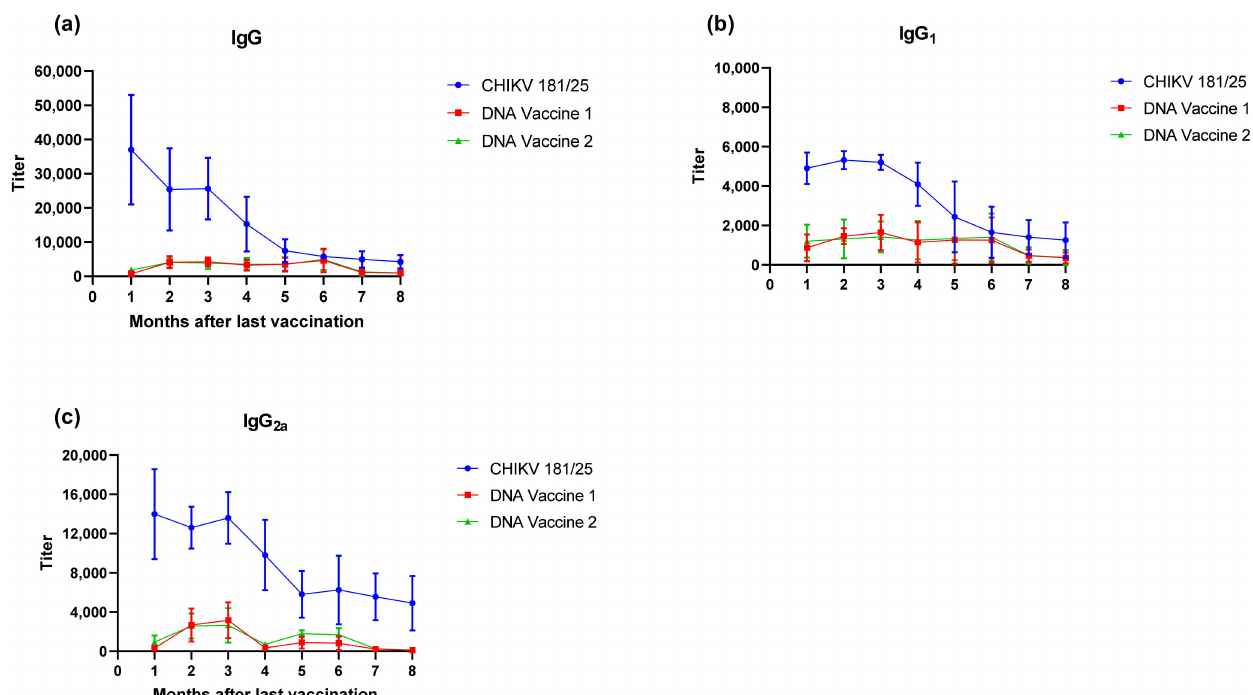
Figure 8. CHIKV antibody titers in BALB/c mice following two doses of DNA vaccine 1, DNA vaccine 2 or the CHIKV 181/25 live attenuated vaccine. ( a ) Total IgG antibody titers over the 8-month study period. ( b ) IgG 1 antibody titers over the 8-month study period. ( c ) IgG 2a antibody titers over the 8-month study